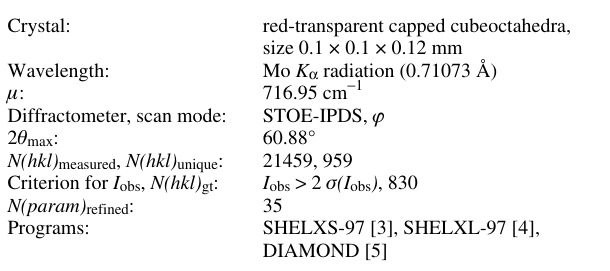
Table 1. Data collection and handling.